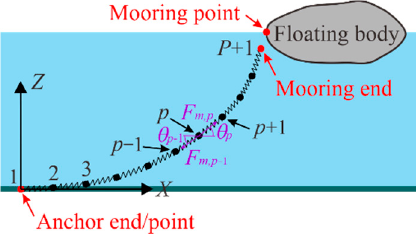
Figure 2. Sketch of the lumped-mass model.